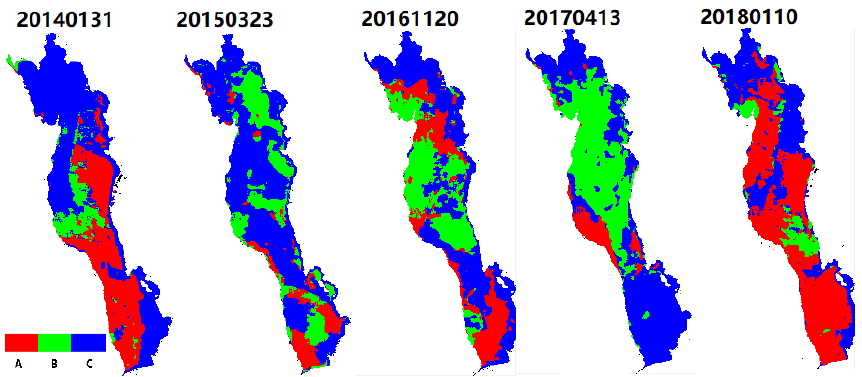
Figure 8. Whole water-body classification in Erhai Lake from 2014 to